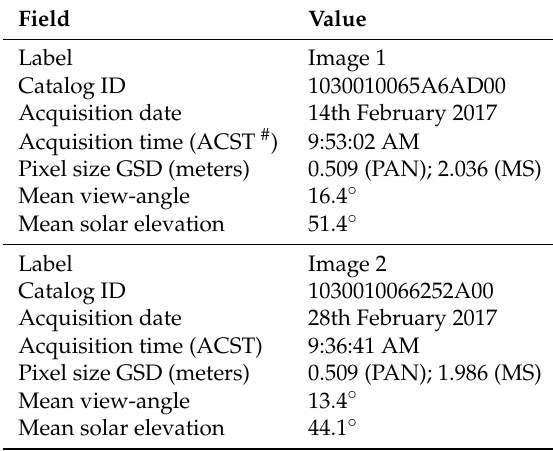
Table A1. Metadata of